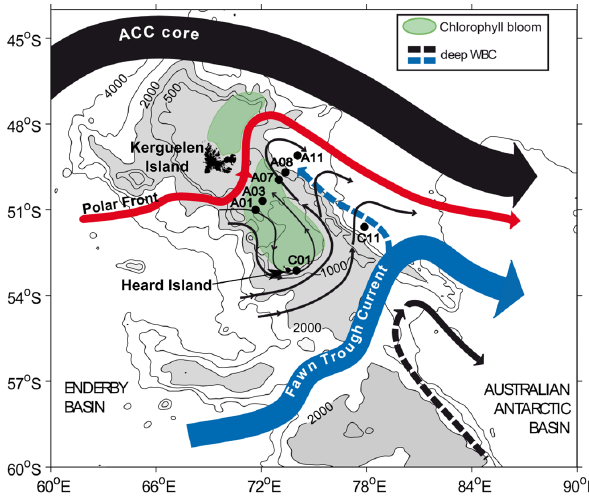
Fig. 1. Sampling locations for dissolved cobalt during the KEOPS cruise (black circles) with bloom location (green area), the bathymetry of the Kerguelen Archipelago and the general circula- tion (arrows). ACC: Antarctic Circumpolar Current; WBC: western boundary current (Park et al.,